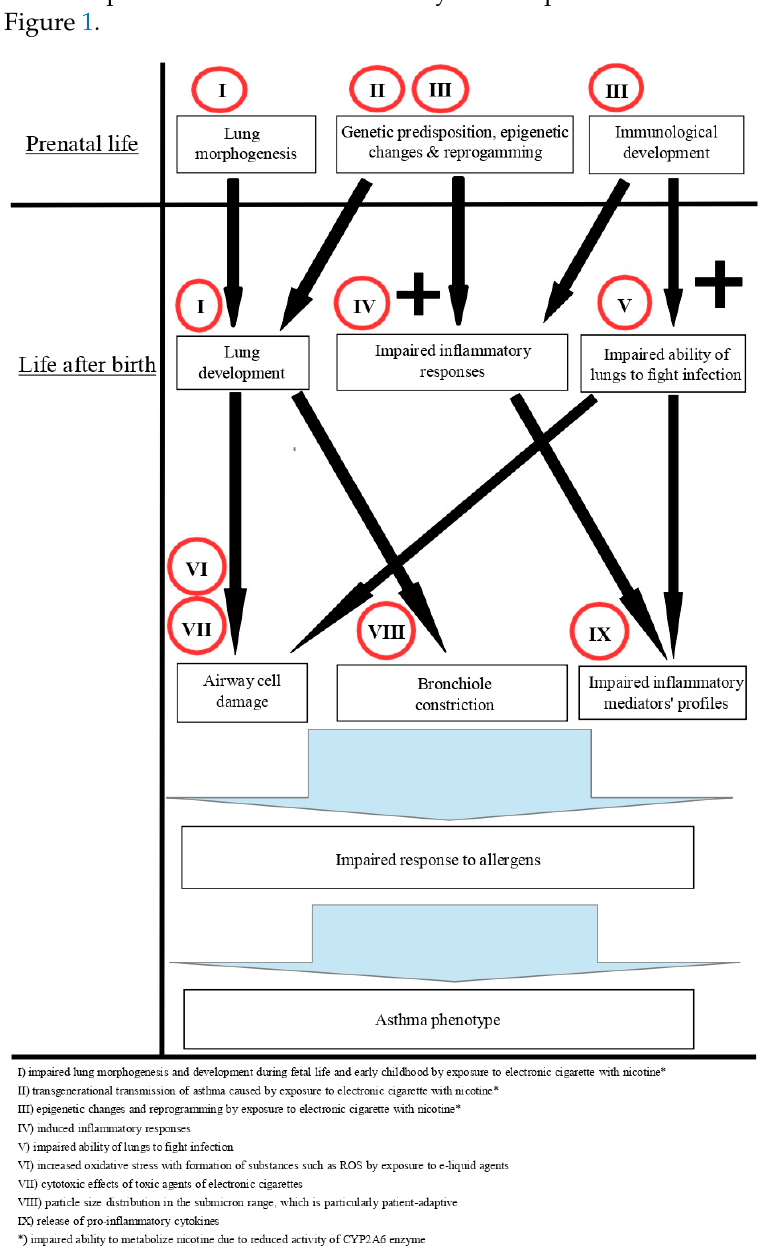
Figure 1. Possible mechanisms whereby electronic cigarette compounds can affect